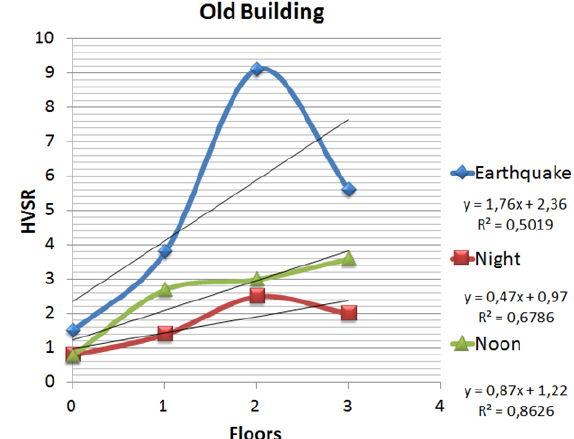
Figure 23. HVSR recordings from the 9 March 2013, 07:43UMT time seismic event (blue line), the 12 March 2013 midnight record- ing (red line) and the 12 March 2013 noon recording of the old building of TEI in Chania.